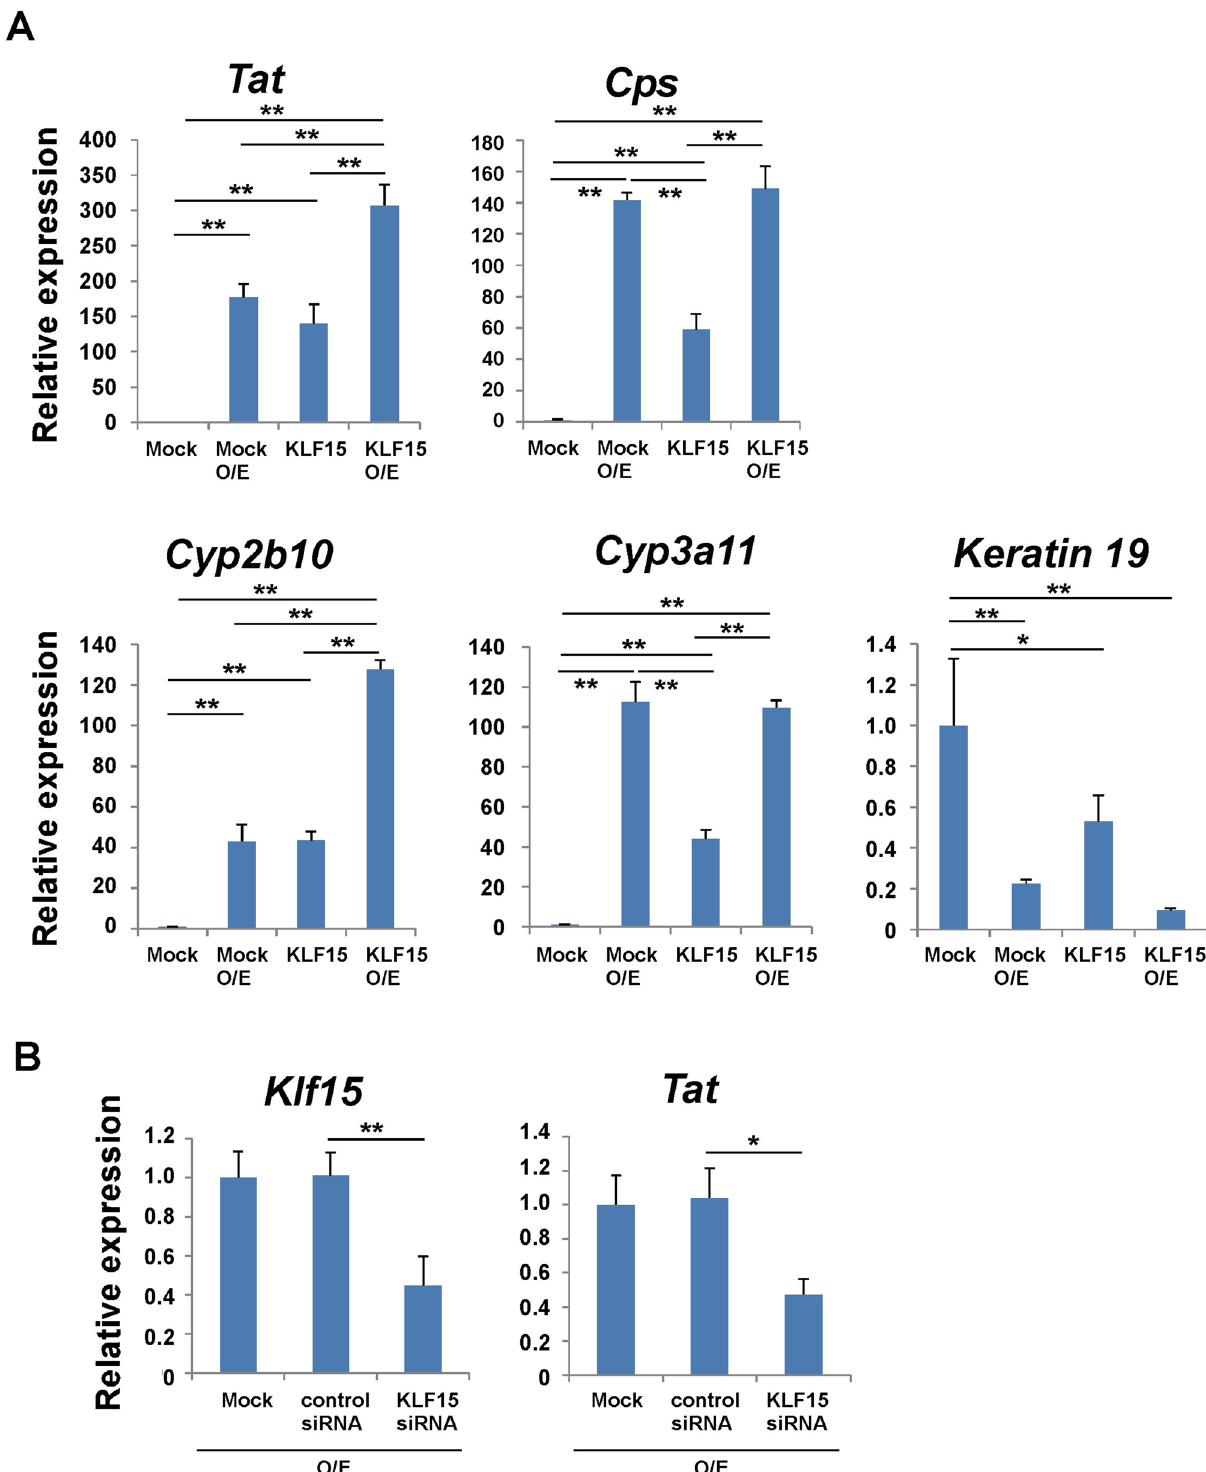
Figure 2. The expression of liver functional genes was regulated by KLF15 in mouse primary hepatoblasts. ( A ) Overexpression of KLF15 in fetal hepatoblasts. As shown in Fig. 1A, after culturing, the expression of Tat , Cps , Cyp2b10 , Cyp3a11 (hepatic genes), and keratin 19 (cholangiocytic gene) were analyzed using quantitative RT-PCR. The expression of genes in cells infected with the mock vector was set to 1.0. ( B ) Knockdown of endogenous KLF15 in hepatoblasts maturation. Hepatoblasts were transfected with Klf15 siRNA by lipofection, and the expression of Klf15 and Tat was analyzed using quantitative RT-PCR. The expression of genes in cells infected with the control siRNA was set to 1.0. Results are represented as the mean expression ± SD (n = 3). *P < 0.05, **P < 0.01. O/E; OSM+extracellular matrix